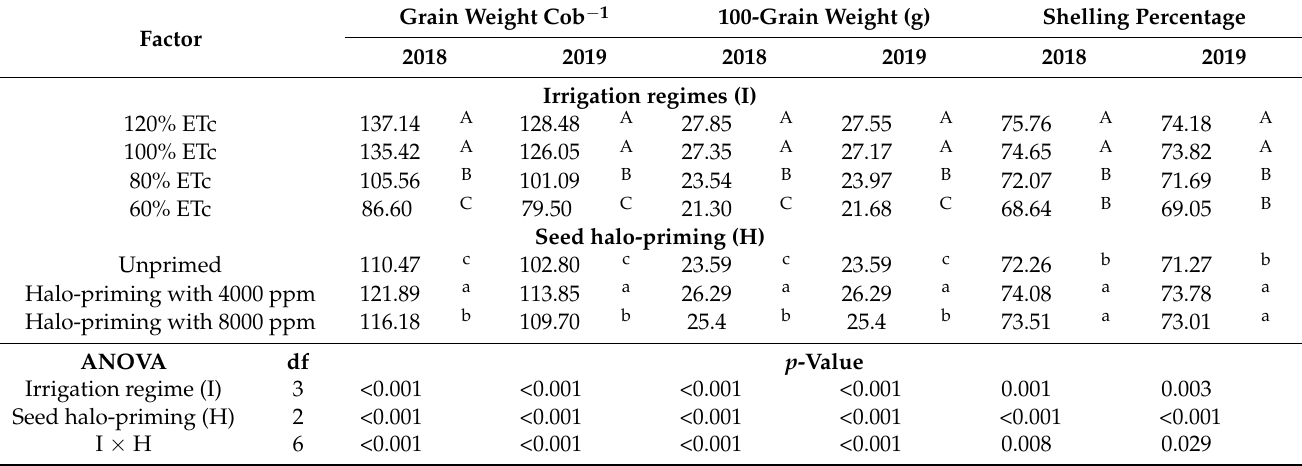
Table 5. Effect of irrigation regimes and seed halo-priming treatments on grain weight cob − 1 , 100-grain weight,